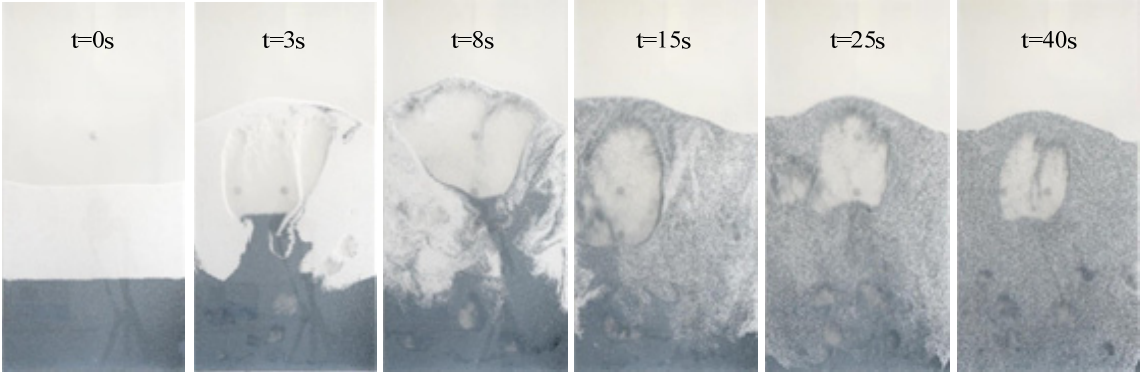
Figure 4. Snapshots of the mixing process of binary solids.